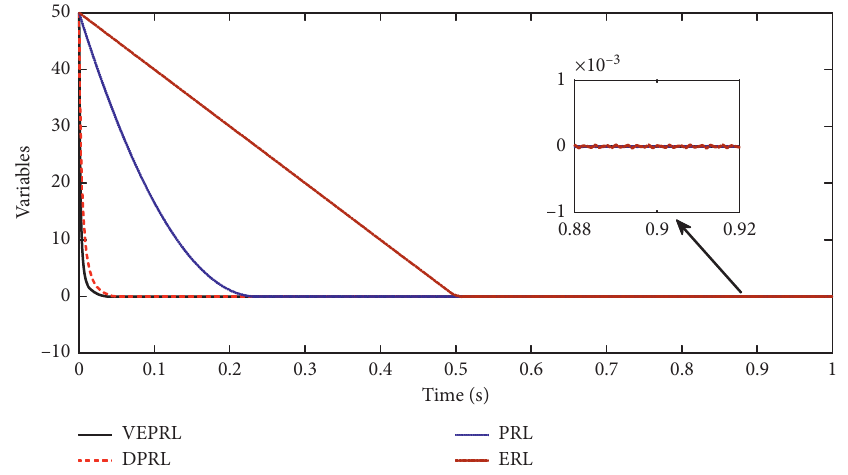
Figure 1: The convergence of different reaching laws.